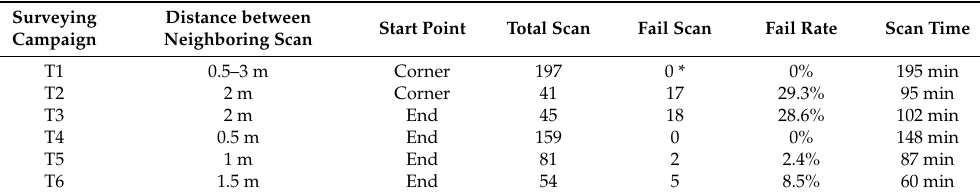
Table 3. General description of dataset collected for the